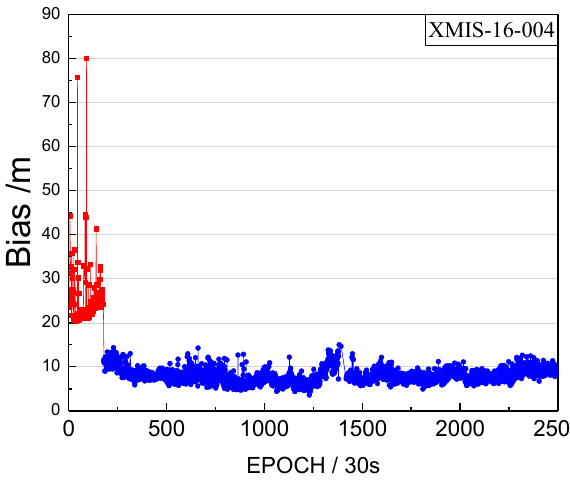
Figure 13. The bias of XMIS between pseudo-range SPP coordinates and the SINEX coordinates on doy 004, 2016. The red section corresponds to the abnormal time